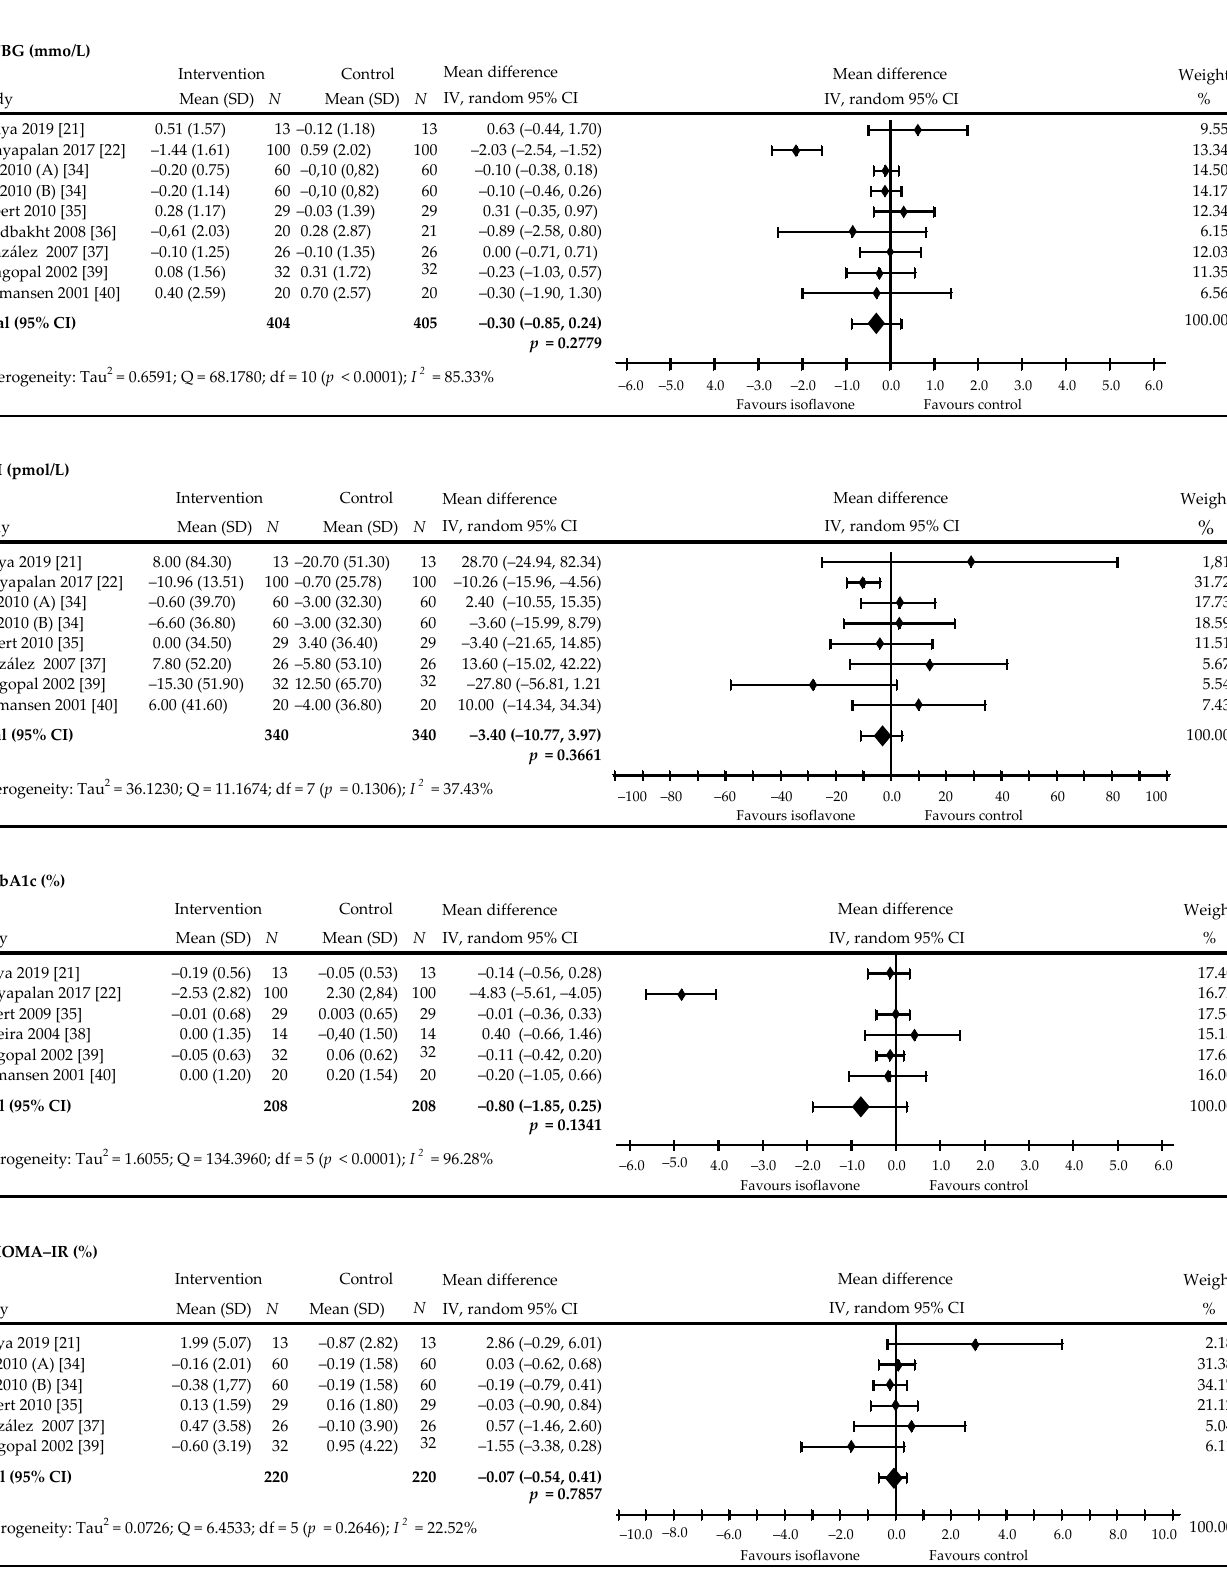
Figure 4. Forest plots showing the difference in glycemic control in all trials between soy isoflavone—administered and control groups. ( A ): FBG, ( B ): FI, ( C ): HbA1c, ( D ): HOMA-IR. Data calculated from the random-effects model are presented as weighted mean difference and 95% CI. The horizontal lines denote the 95% CIs, some of which extend beyond the limits of the scales. Letter in parentheses following the author’s name indicate a study with more than one treatment arm.